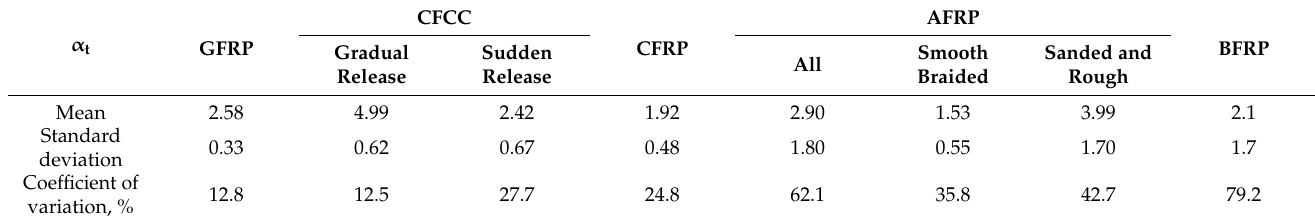
Table 11. Results for the coefficient α t